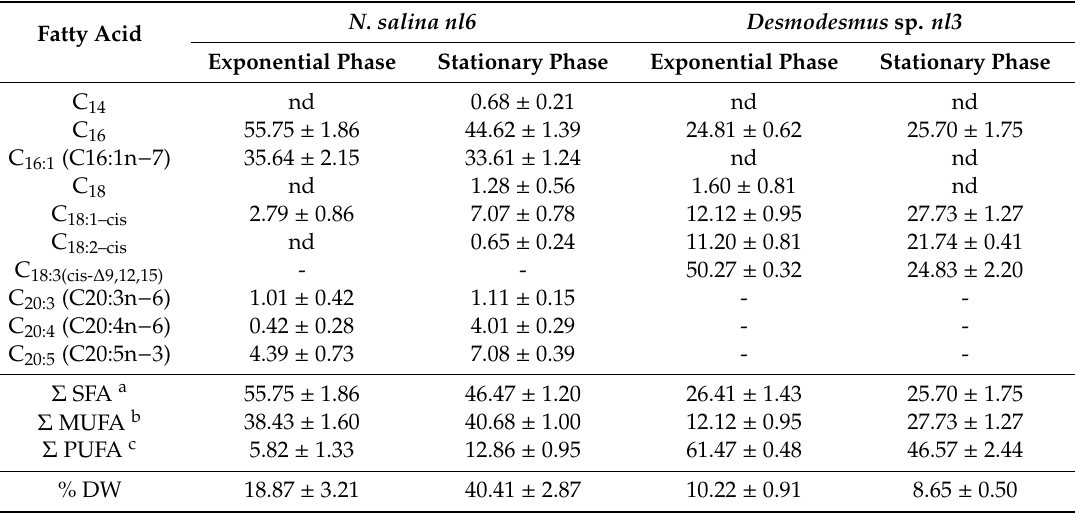
Table 3. Fatty acid profiles of N. salina nl6 (F / 2 medium 24% (cid:24) salinity) and Desmodesmus sp. nl3 (TAP medium) in exponential and stationary phases (n = 3). Fatty